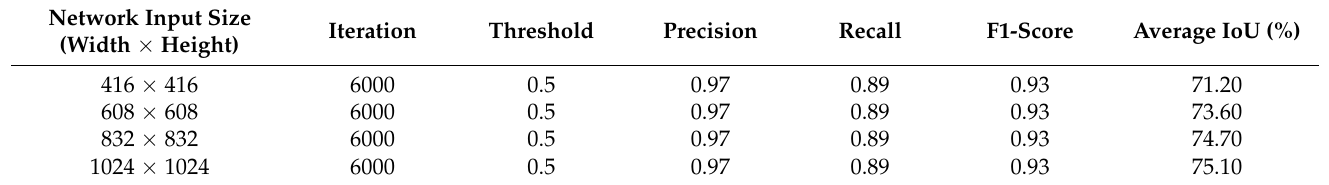
Table 8. The best model for each network input size on YOLOv5m is based on training and validation.